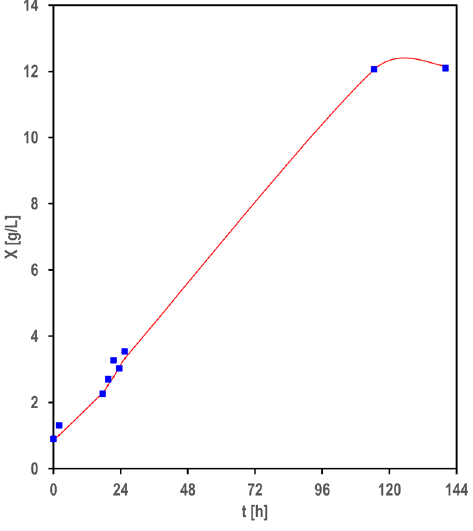
Figure 1. Growth kinetics of C. maltosa SM4 on RBY for 200 rpm, 1 L min − 1 . Biomass production actually achieved in the experiments ( ) and predicted by the logistic model (—).